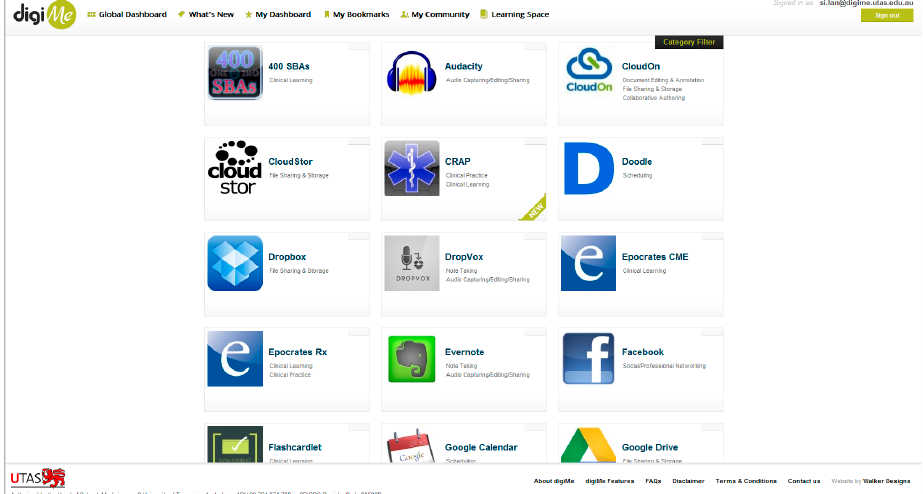
Figure 1. digiMe Global Dashboard interface.